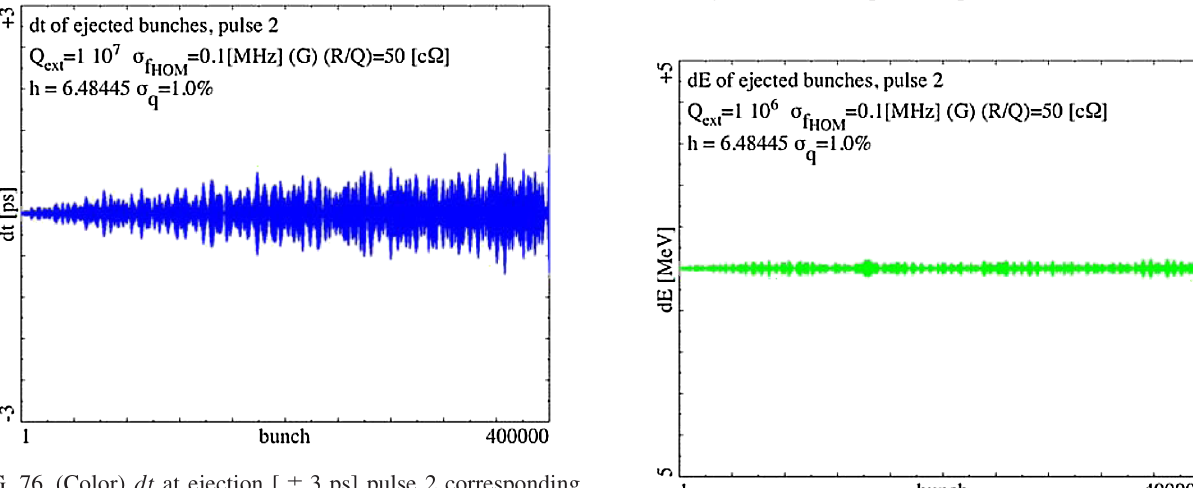
FIG. 76. (Color) dt at ejection [ (cid:3) 3 ps ] pulse 2 corresponding to Fig. 11 (equivalent to Fig. 62 but Q ext ¼ 10 7 ). The displayed 2nd pulse starts at zero amplitude here since no significant fields survive the beam-pulse pause at Q ext ¼ 10 7 .